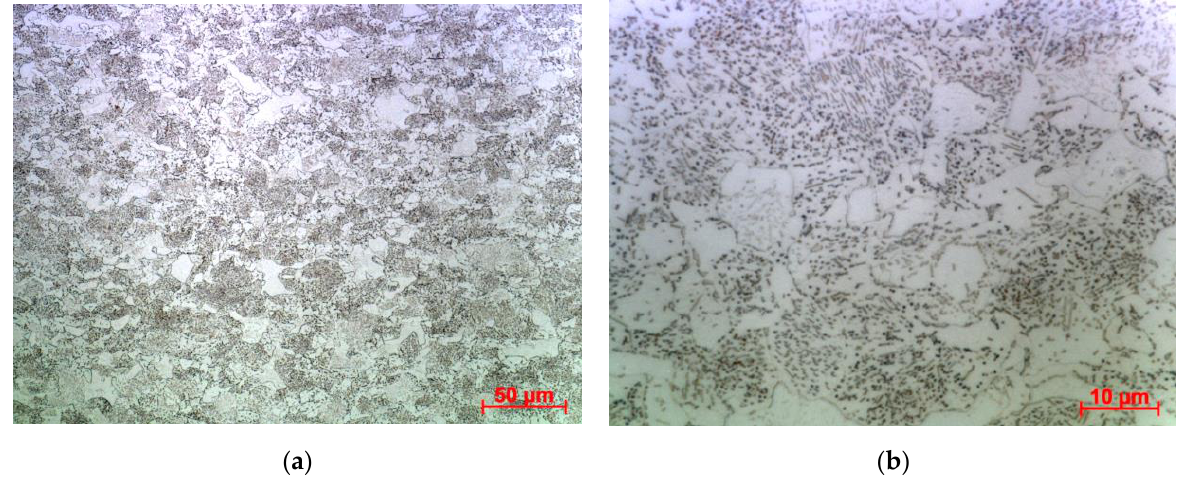
Figure 2. 30 KhGSA steel microstructure: ( a ) — 200× magnification; ( b ) — 1000× magnification.